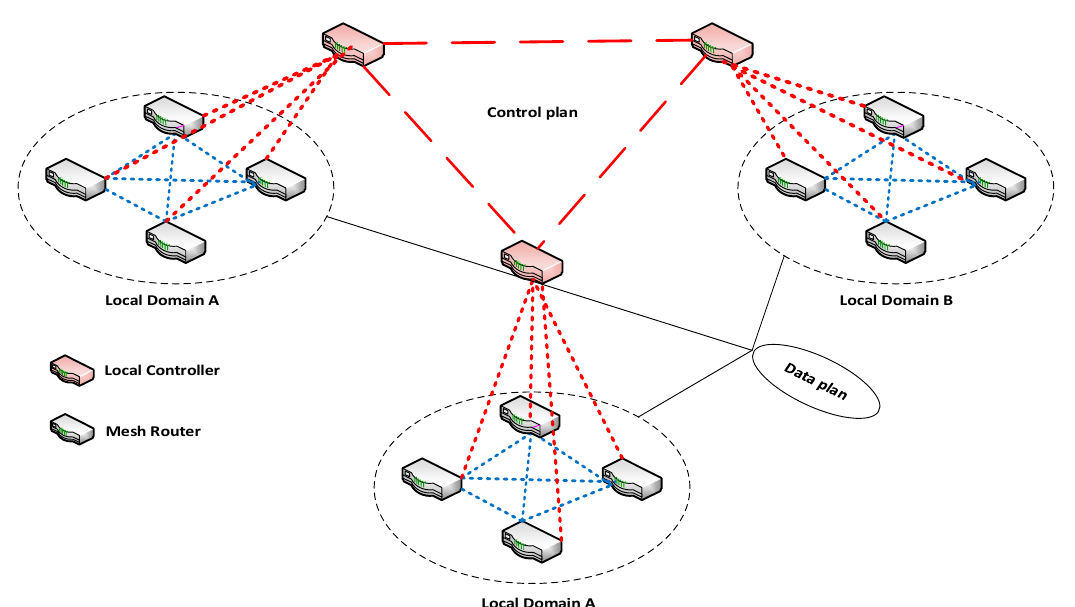
Figure 1. Flat Distributed-Software Defined Wireless Mesh Network (FD-SDWMN) flat architecture.